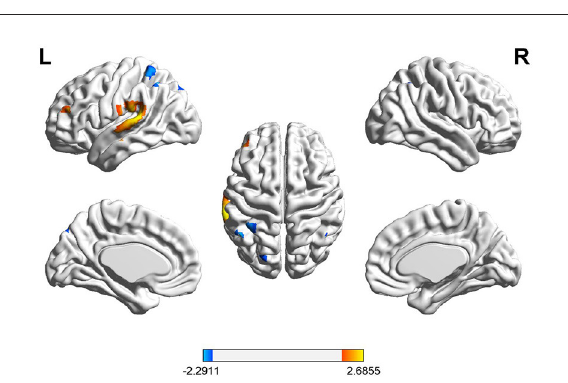
FIGURE3 Cortical activation associated with the picture-naming task. HbO activation maps between patients with global aphasia and healthy individuals. The color bar represents the t -statistic. Warmer colors with positive values represent increases in HbO in patients with global aphasia compared with healthy individuals, while cooler colors with negative values represent opposite results ( p <